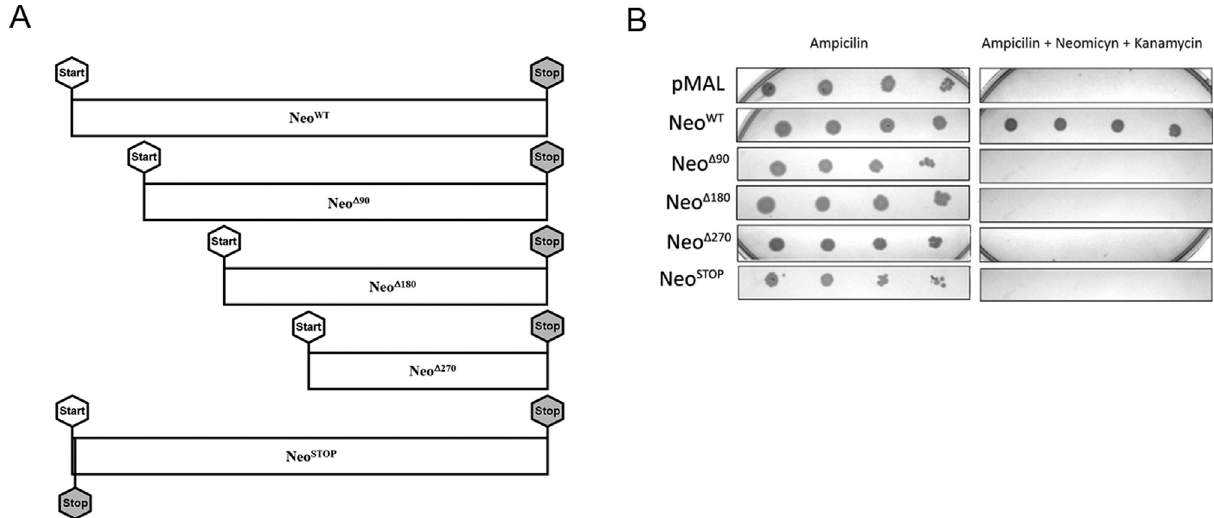
Figure 1 - The N-terminal region of Neo is required to promote resistance against kanamycin. Wild-type Neo gene (Neo WT ) and its variants (Neo (cid:2) 90 , Neo (cid:2) 180 , Neo (cid:2) 270 and Neo STOP ) were obtained as described in Materials and Methods, item 1, and kanamycin- and neomycin-resistance assay was con- ducted as described in Materials and Methods, item 2. (A) Diagram depicting wild-type Neo gene and deletions of N-terminal segments, which give rise